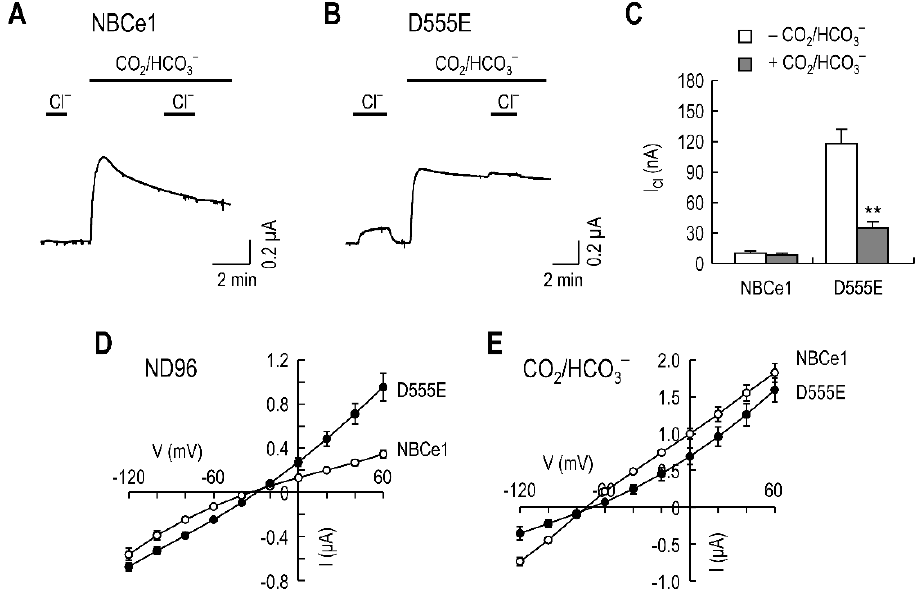
Figure 1. D555E produces I Cl . ( A ) Representative I Cl and I NBC produced by NBCe1. An oocyte expressing NBCe1 was superfused with modified Cl − -free ND96 until the basal current became stable, and then exposed to 71 mM Cl − before and after switching solutions equilibrated with 5% CO 2 , 25 mM HCO 3 − . The holding potential was − 60 mV. ( B ) Representative I Cl and I NBC , produced by D555E. The recording was performed, as described in ( A ). ( C ) Mean I Cl , in the absence and presence of CO 2 /HCO 3 − . I Cl was measured when the current reached steady-state after Cl − application ( n = 6/group); ** p < 0.01 compared to I Cl in the absence of CO 2 /HCO 3 − . ( D , E ) I–V relationships of NBCe1 and D555E for I Cl in ND96 ( D ) and CO 2 /HCO 3 − ( E ). Currents were obtained by a step voltage command from − 120 to +60 mV with 20 mV increments ( n = 5/group).